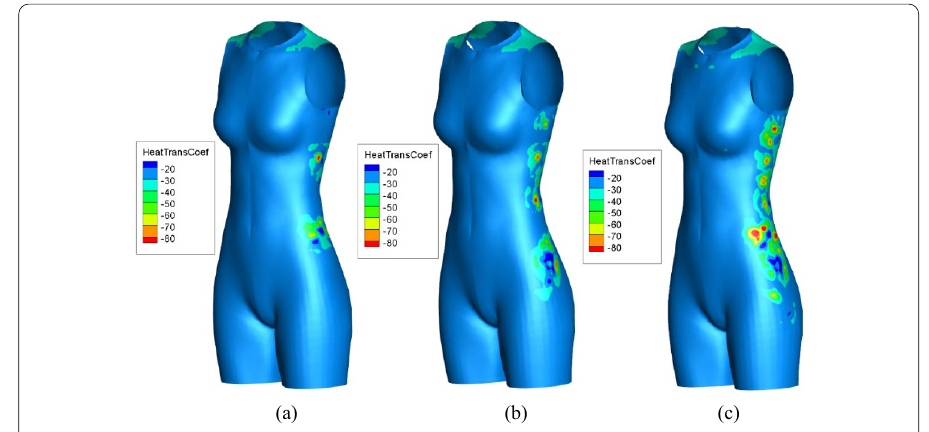
Fig. 7 Heat flux contours for different cases. a Case 1, two fans, b case 2, four fans, c case 3, eight